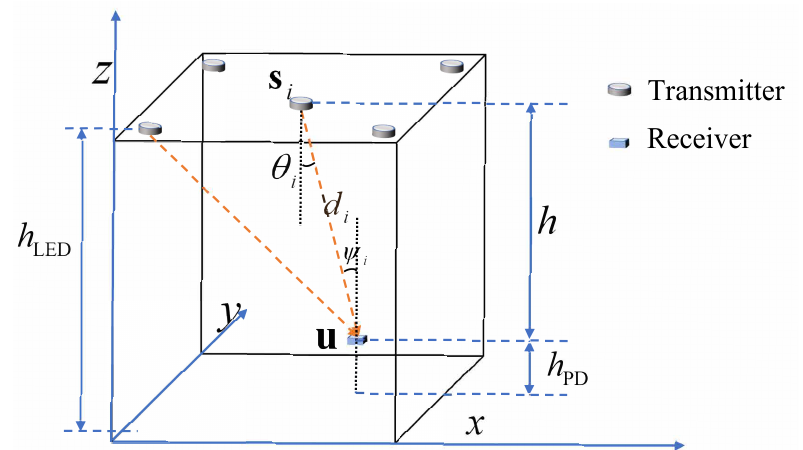
Figure 1. The basic model of